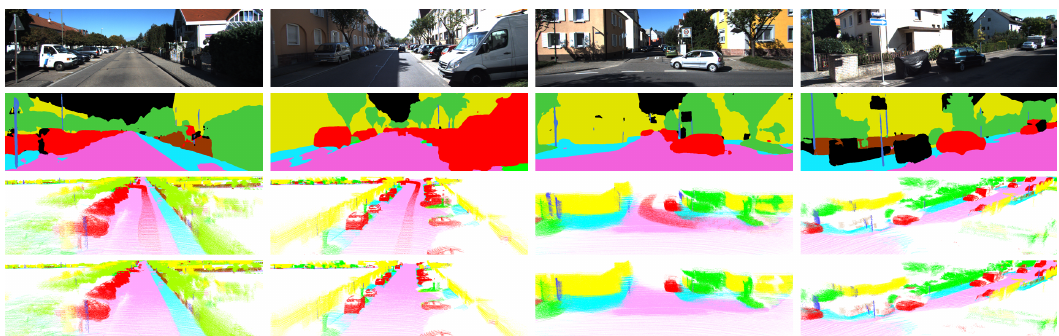
Figure 8. Effectiveness of the map refinement. (First Row) original images. (Second Row) 2D semantic segmentation. (Third Row) semantic 3D map without map refinement. (Bottom Row) semantic 3D map with map refinement.